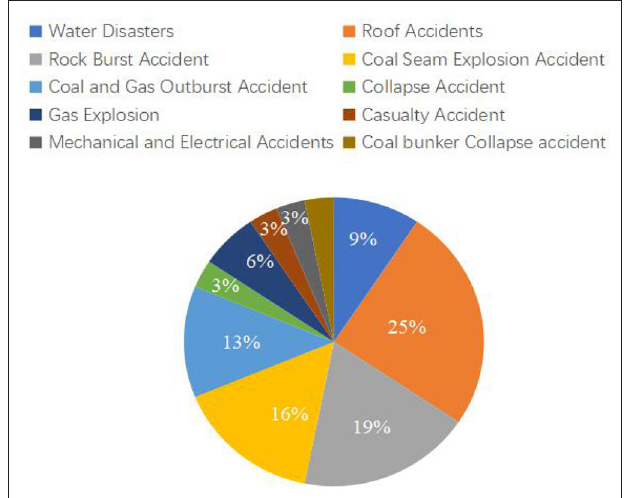
FIGURE 4 | Statistics of coal mine